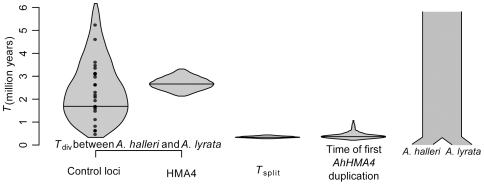
Coincidence of speciation time of Arabidopsis halleri and A. lyrata and the first duplication of the AhHMA4 gene.Distributions show the 95% HPD of (1) the average time of divergence (Tdiv) per locus between any A. halleri and A. lyrata lineages estimated as Tdiv = K
syn/(2.μ) where K
syn is the observed synonymous divergence per locus and μ the synonymous mutation rate- black dots represent the observed values at 29 loci; (2) the divergence time between A. halleri and A. lyrata gene copies at HMA4 locus estimated with BEAST; (3) the time of speciation (Tsplit) under the best model obtained using our ABC approach; and (4) the time of the first duplication at AhHMA4 estimated with BEAST. Thick horizontal lines represent the mode of each distribution.